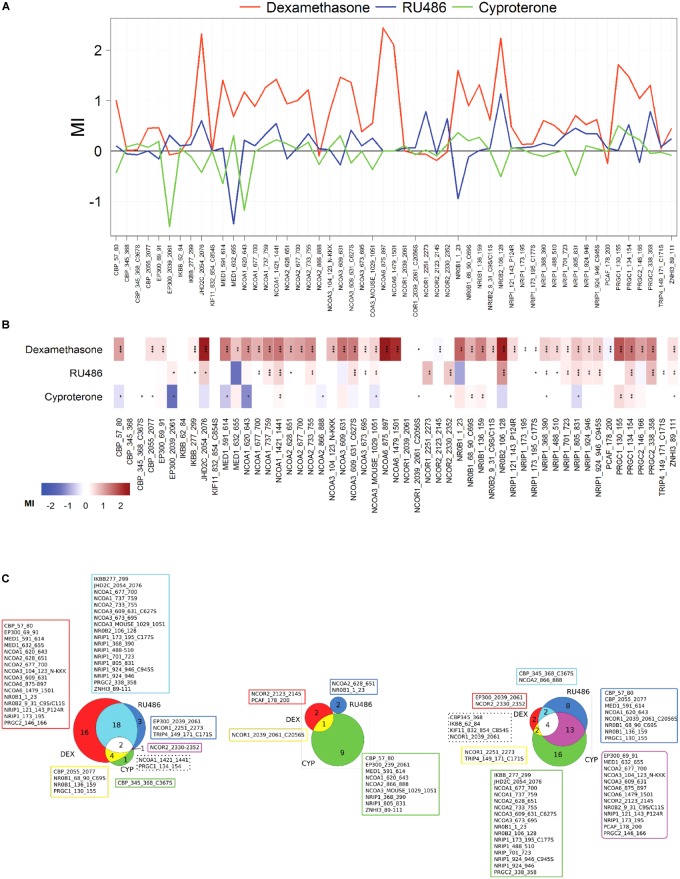
DEX, RU486 and CYP induce specific GR LBD-to-NR box peptide binding profiles. (A) Characteristic binding profiles induced by 1 × 10-7 DEX (red), RU486 (blue) or CYP (green) obtained using the quantitative in vitro assay, MARCoNI. Modulation Index (MI) > 0 suggests ligand-favored binding, while MI < 0 suggests ligand-disfavored binding of a peptide compared to DMSO. (B) Heatmap depiction of details of ligand-induced binding of coregulator peptides using MARCoNI. (C) Venn diagrams showing the number of peptides whose binding was favored (left), unfavored (center) or unchanged (right) by GR ligands. In all cases, statistically significant changes relative to DMSO were identified by Student’s t-test. ∗p < 0.05, ∗∗p < 0.01 or ∗∗∗p < 0.001.